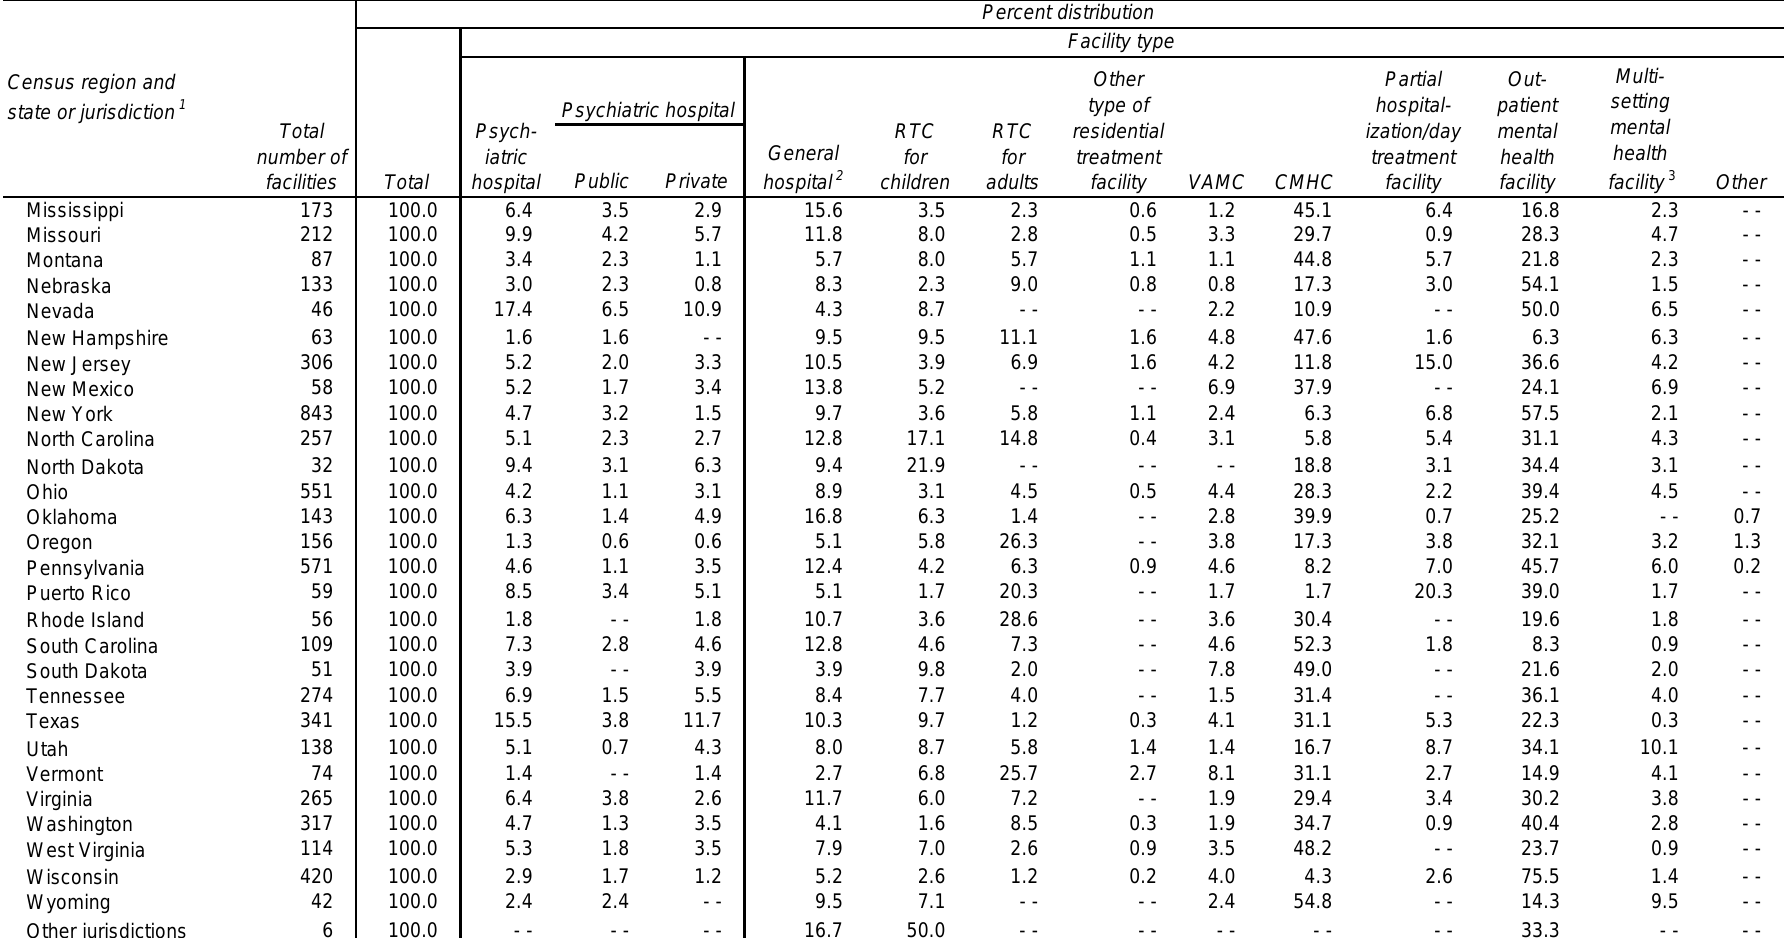
Table 3.1b. Mental health treatment facilities, by facility type, Census region, and state or jurisdiction: Percent, 2017 (continued)